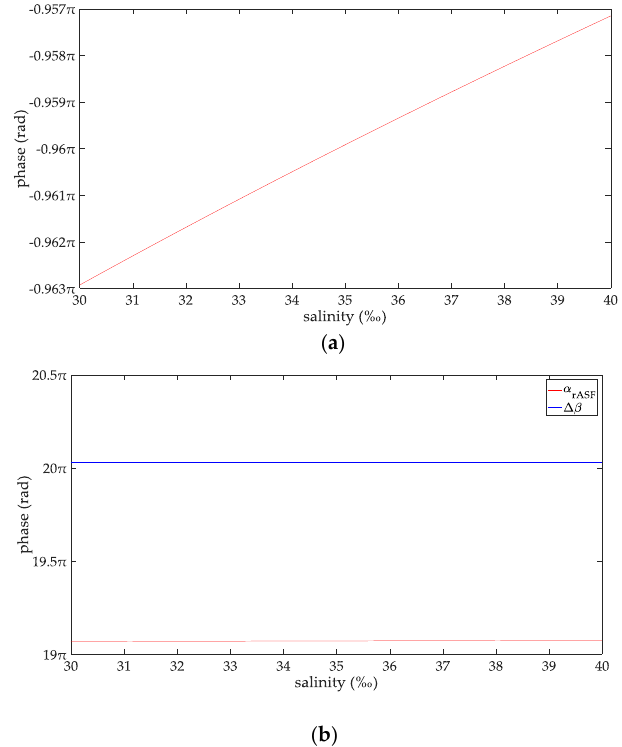
Figure 4. ( a ) The phases of the reflection coefficient changing with the sea salinity; and ( b ) the ASFs of the AIS reflected signal changing with the sea salinity.